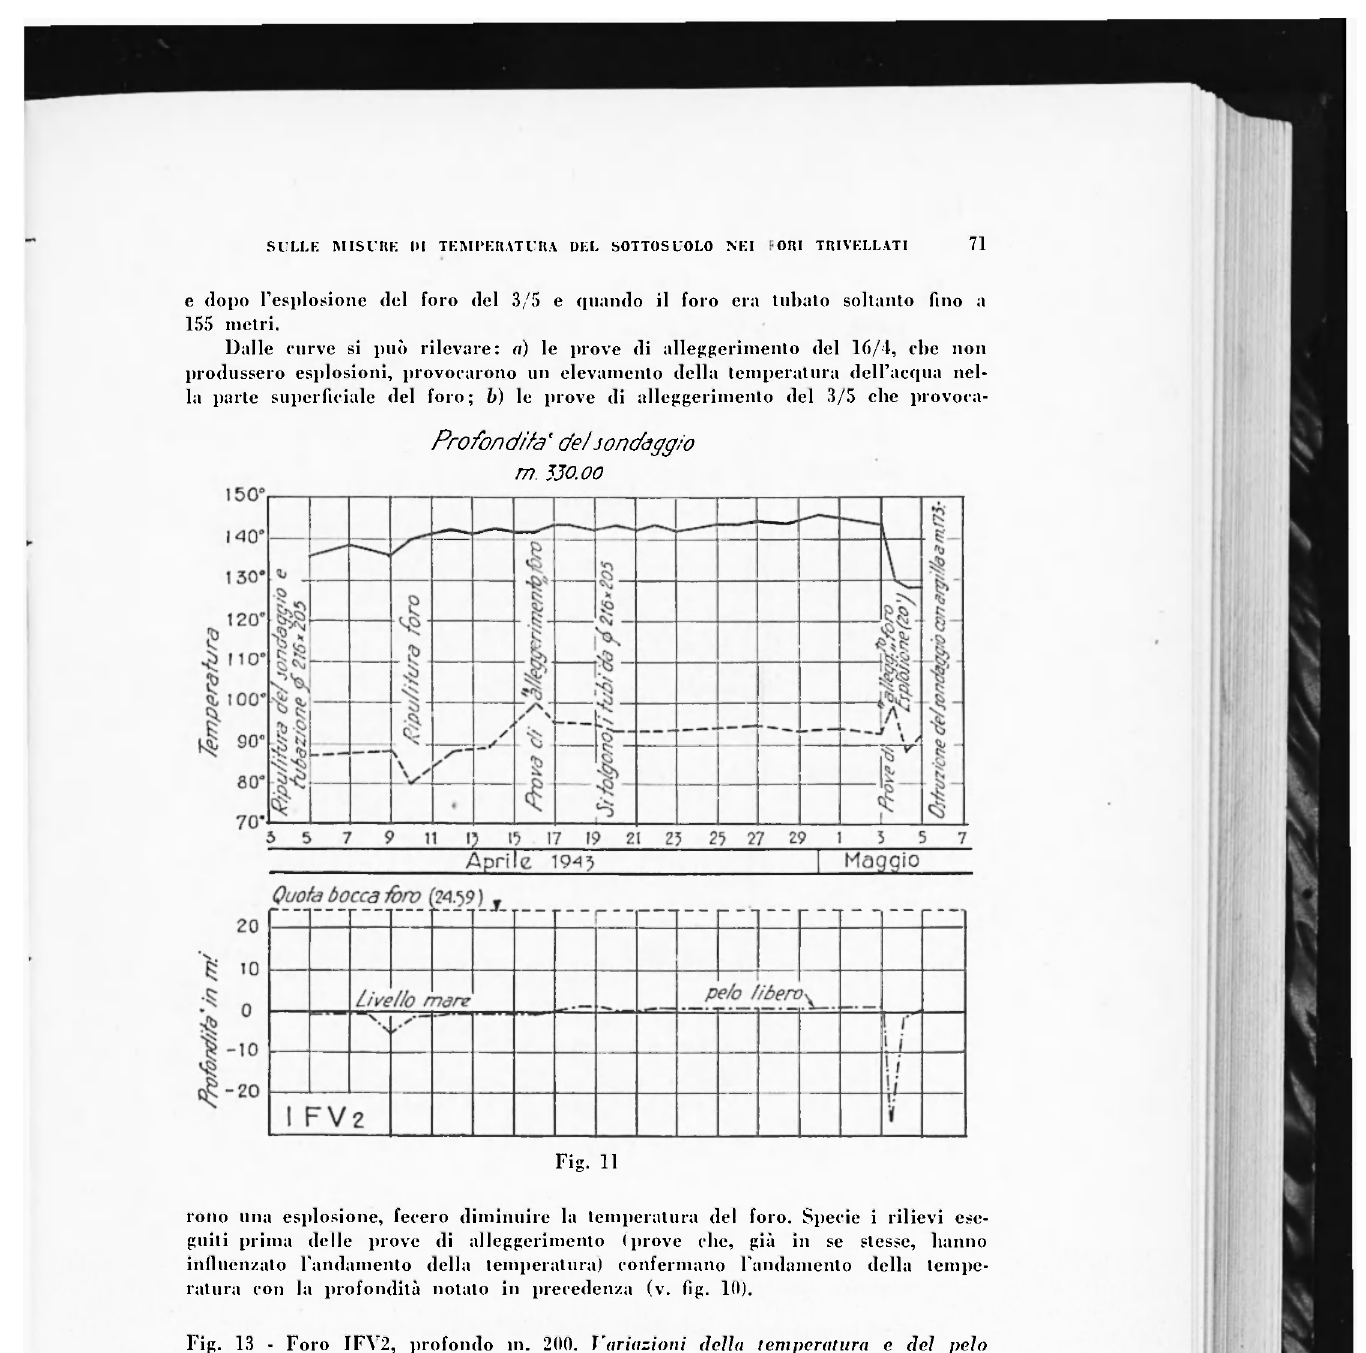
rollo una esplosione, fecero diminuire la temperatura del foro. Specie i rilievi ese- guiti prima delle prove di alleggerimento (prove che, già in se stesse, hanno influenzato l'andamento della temperatura) confermano l'andamento della tempe- ratura con la profondità notato in precedenza (v. fig. 1(1). Fig. 13 - Foro IFV2, profondo in. 200. Variazioni della temperatura e del pelo libero dell'acqua dopo il riempimento del foro fino a m